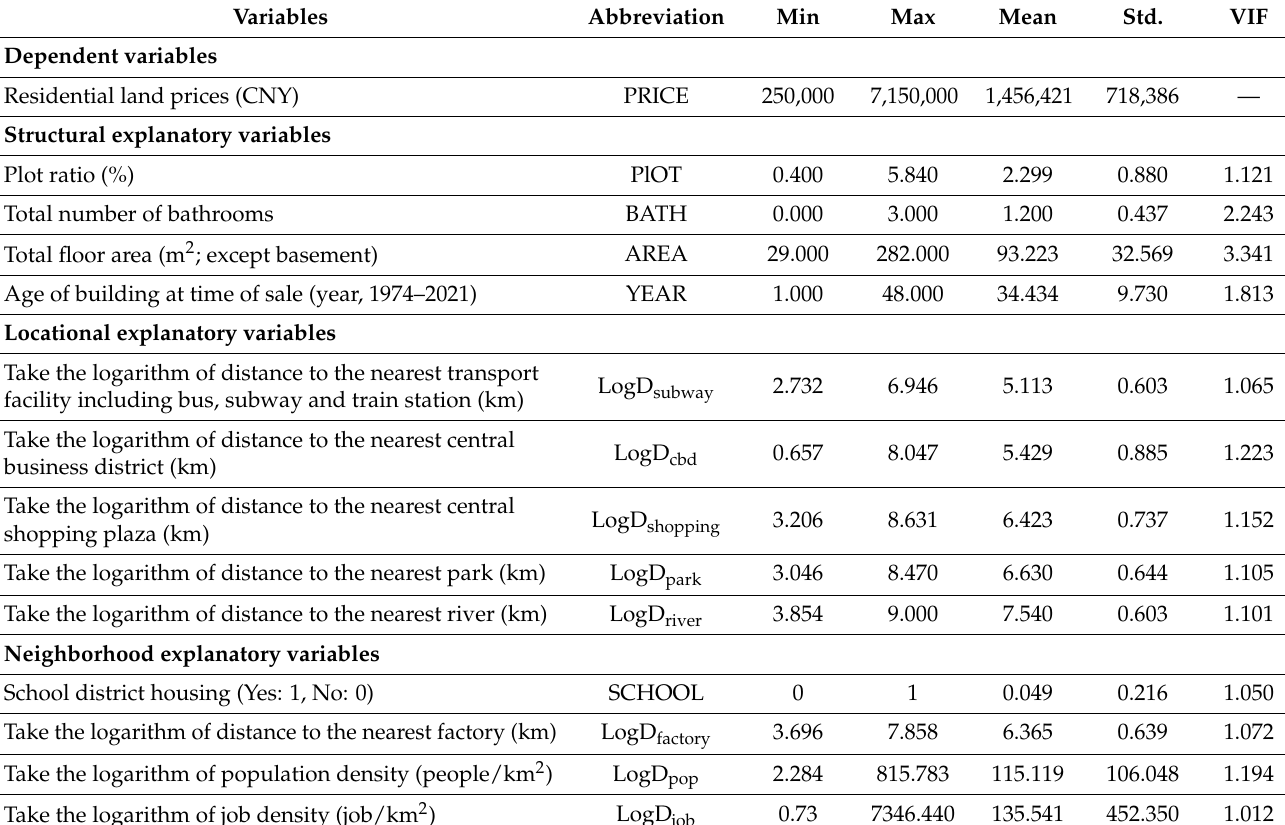
Table 1. The definitions of the dependent and independent